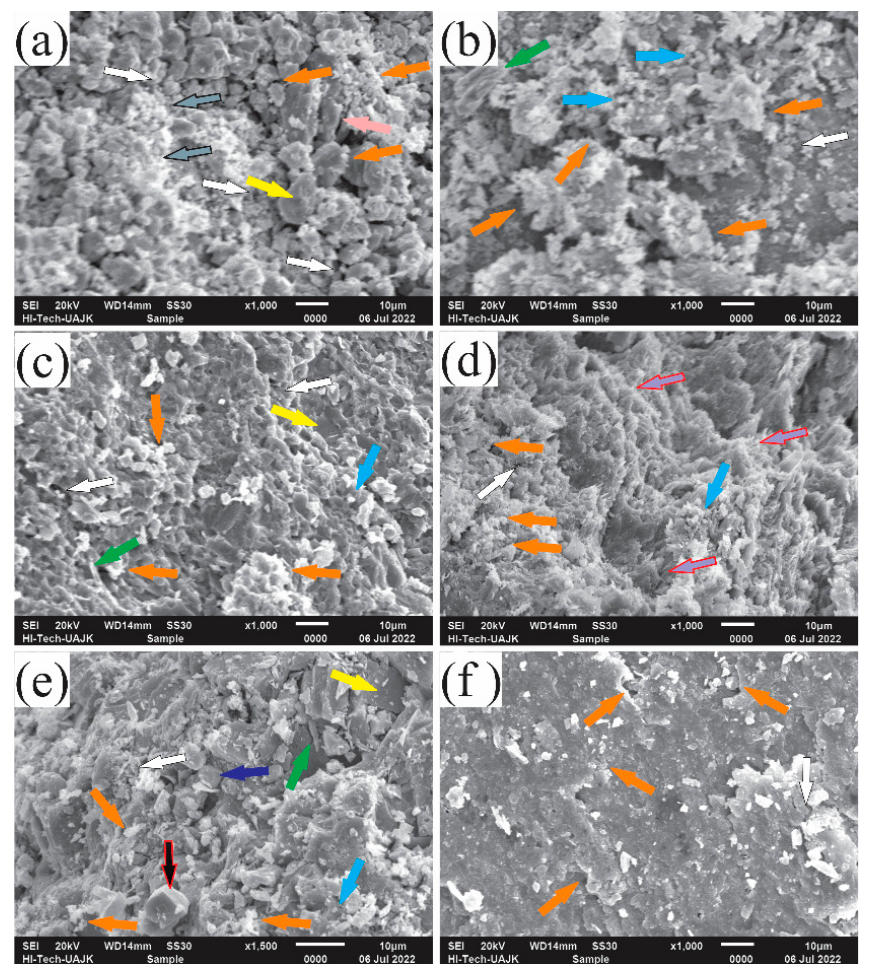
Figure 16. SEM image of shales and limestone samples from the Middle Eocene Chorgali Formation. ( a , b ) Images of the samples obtained from the base of the Chorgali Formation; ( c , d ) Images of the samples taken from the middle of the Chorgali Formation; ( e , f ) Images denote samples obtained from top of the Chorgali Formation. Refer to the caption of Figure 15 above for an explanation of the arrow